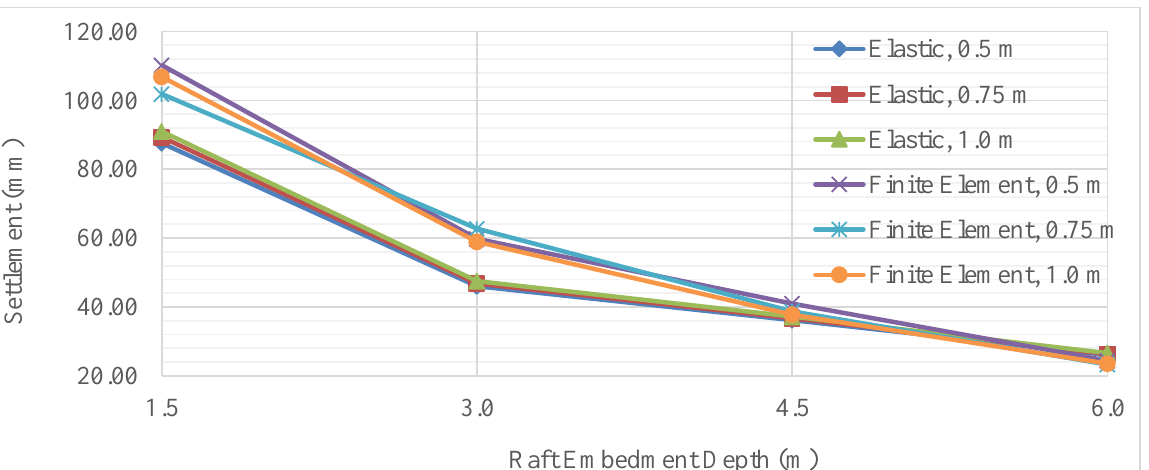
Fig. 14. Settlement versus depth showing the effect of raft thickness for 400 kN/m 2